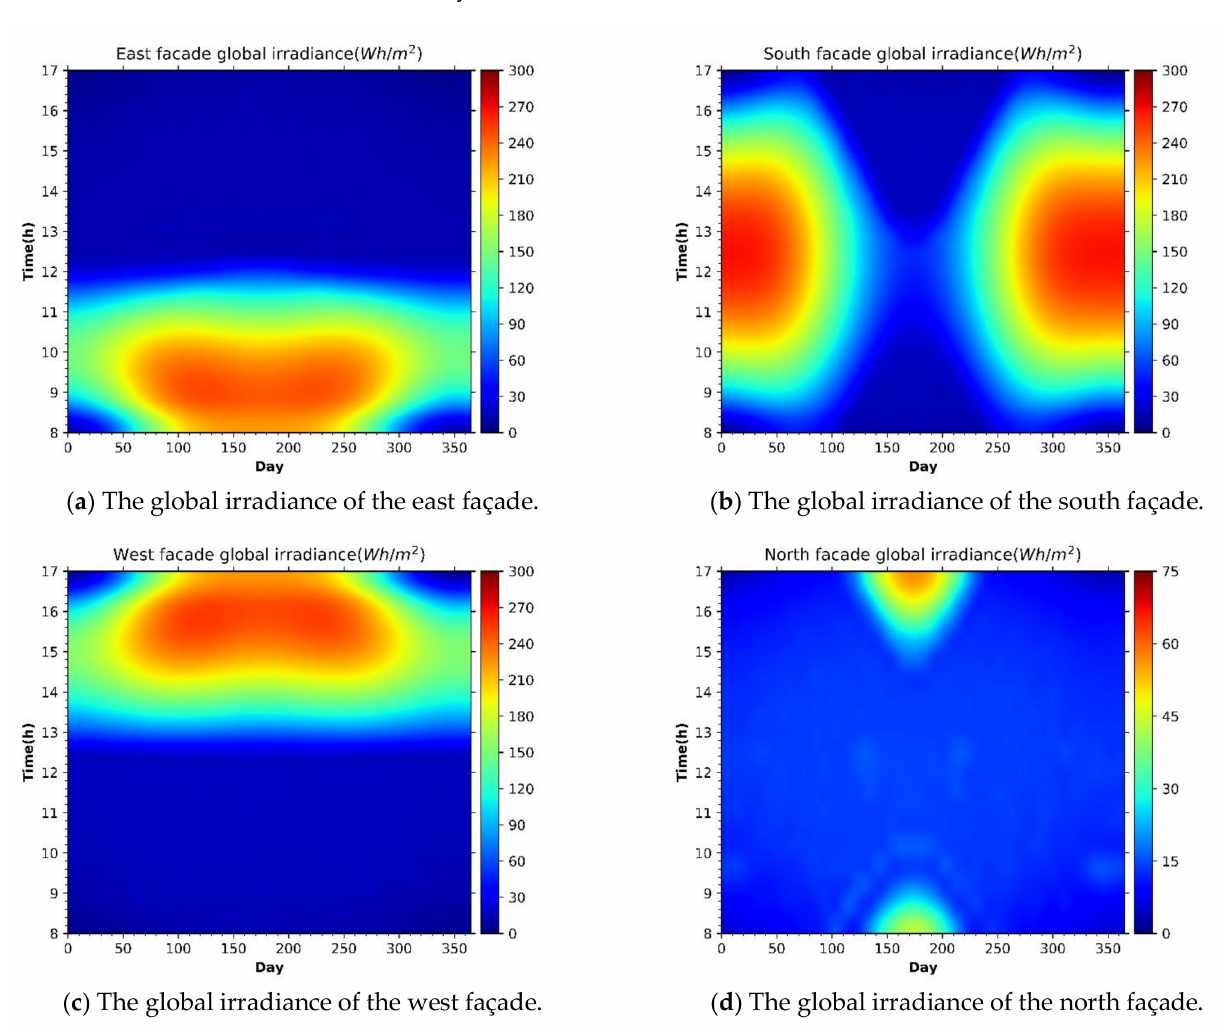
Figure 16. Global irradiance per hour in different directions.